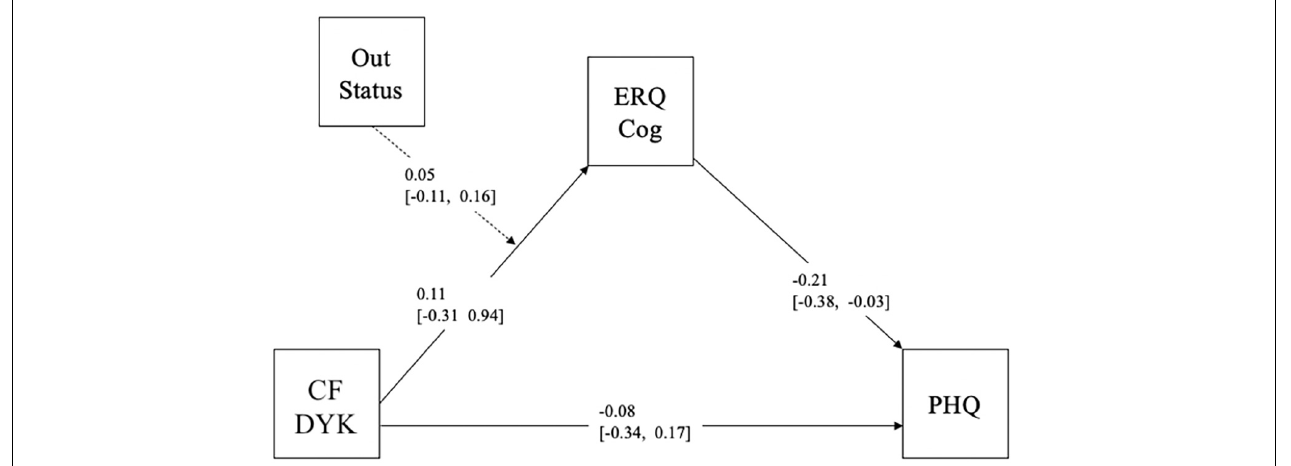
FIGURE 2 | Overall model SMW. Out Status, Outness; CF DYK, Chosen Family Do You Know; ERQ Cog, Emotion Regulation Questionnaire-Cognitive Reappraisals; PHQ, Patient Health